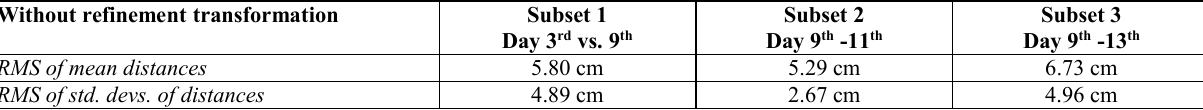
Table 4. RMS and std. devs. of the distances between representative points in corresponding blocks and various subsets without the application of a refinement transformation to mitigate possible systematic errors.